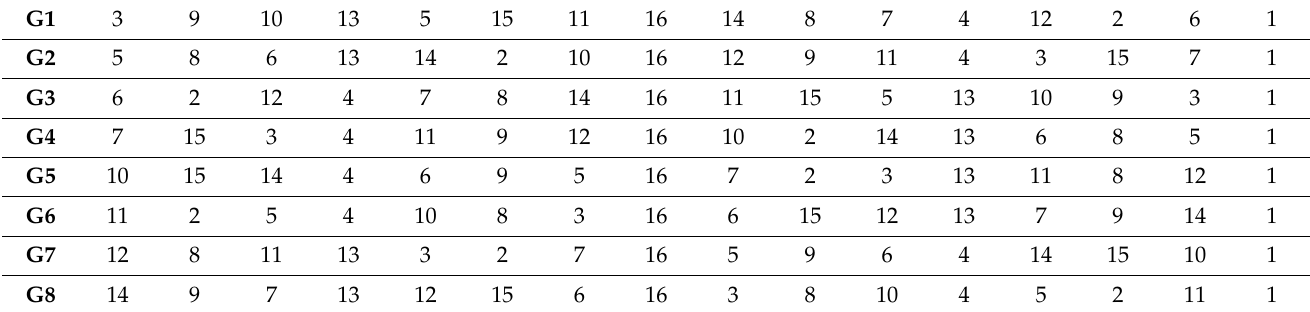
Table 3. Generated cyclic group of 17 orders.